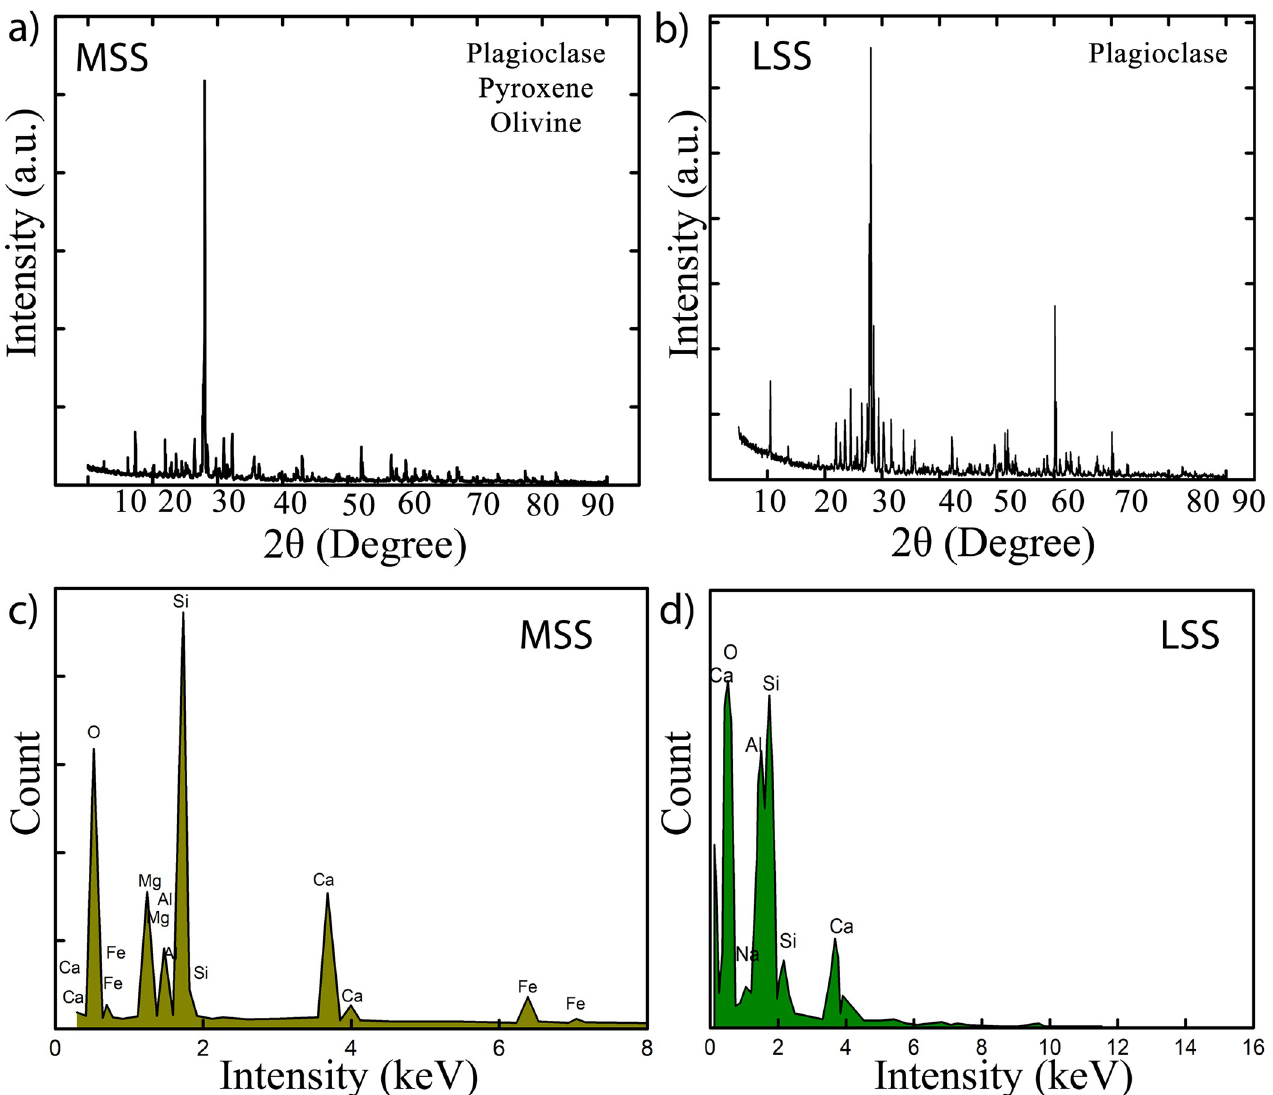
Fig 4. XRD pattern and EDS of raw soil simulants a) identified crystalline phases of MSS b) identified crystalline phases of LSS c) elemental mapping of selected location of MSS d) elemental mapping of selected location of LSS.